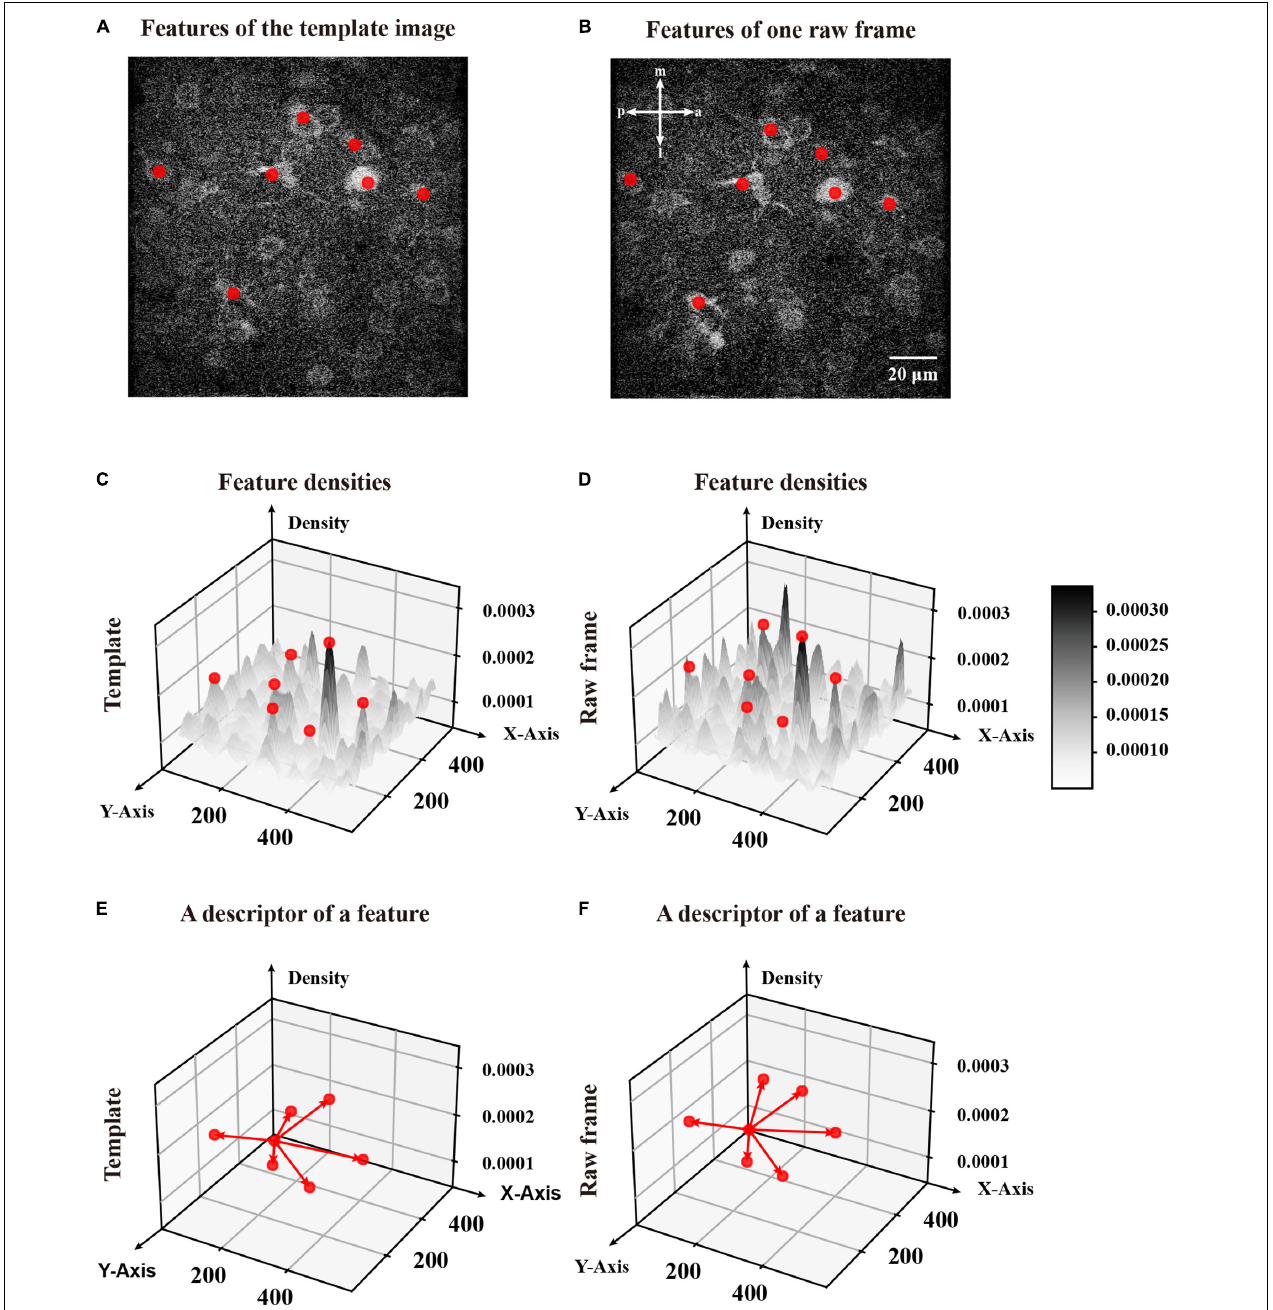
FIGURE 6 | A visualization of the process to generate the descriptor. (A) The features for the template image obtained by FIFER features are marked by red dots. (B) A raw frame to be corrected with its corresponding features. (C) The density distribution of the template image with corresponding features. (D) The density distribution of the raw frame with corresponding features. The density maps in panels (C) and (D) are indicated with the grayscale bar painted on the right. (E) The descriptor of a feature selected from the template image. (F) The descriptor of a feature from the raw frame. This descriptor represents a collection of the differences between itself and all the other features in panels (E,F) .